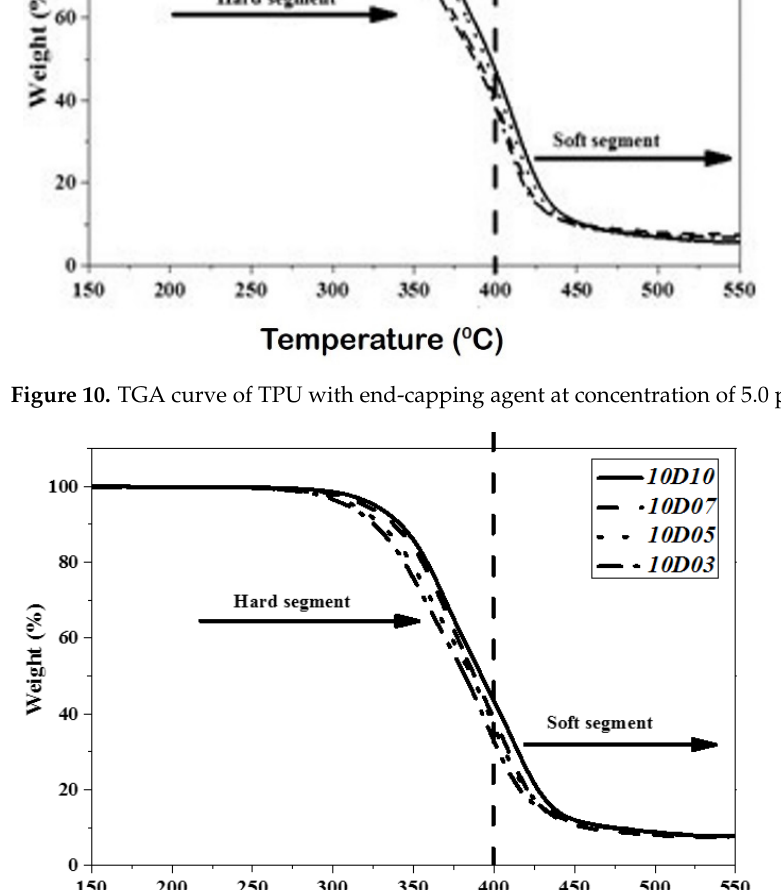
Figure 11. TGA curve of TPU with end-capping agent at concentration of 10 phm.